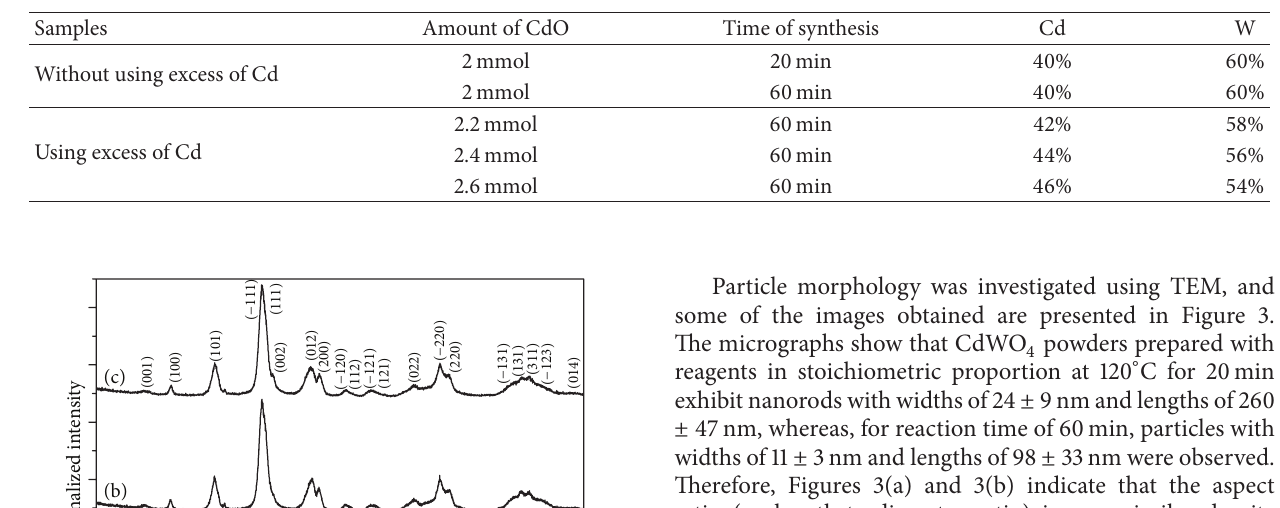
Table 1: EDX results for atomic composition of the samples.